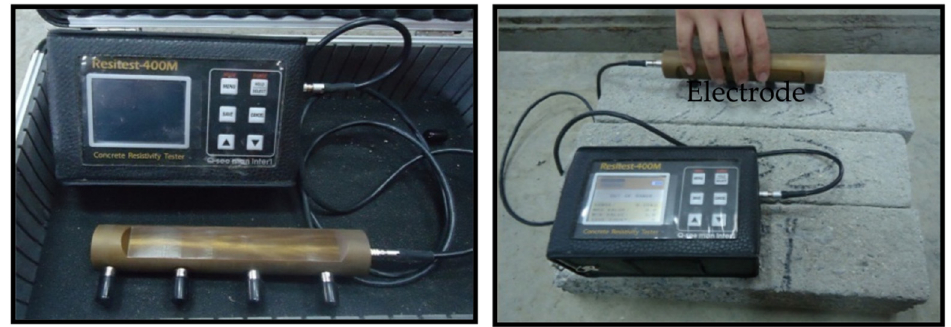
Figure 3. Four probe resistivity test device.